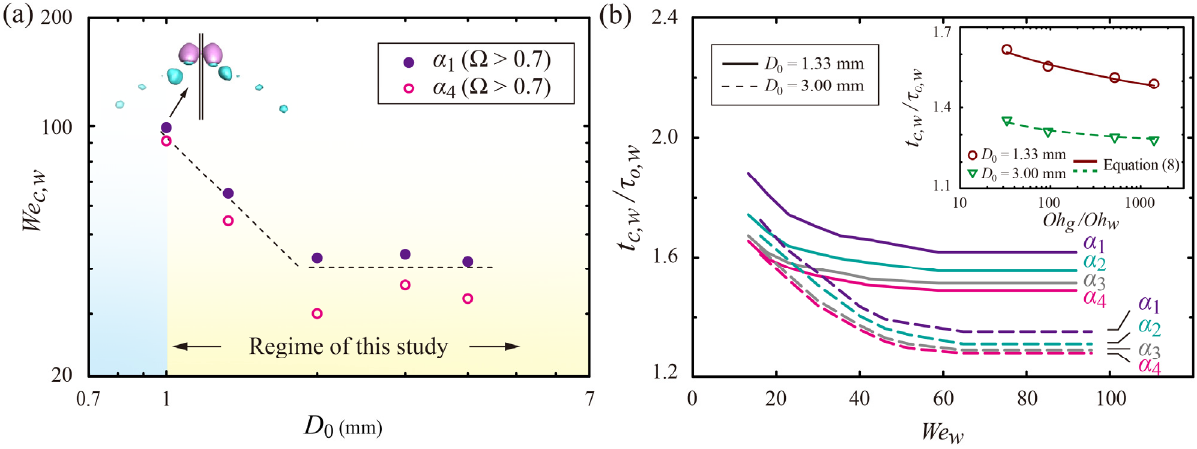
Figure 5. ( a ) We w thresholds for the separation under different drop sizes. Filled and open symbols represent the thresholds under the viscosity ratios of α 1 and α 4 , respectively. ( b ) Residence time of W-parts normalized by τ o,w as a function of We w at two distinct drop diameters. The inset represents the normalized residence time as a function of Oh g / Oh w , obtained from numerical data (symbols) and predictions from Equation (8) (lines) under the high- We w regime. The data regarding D 0 = 2.0 mm in ( a ) are reprinted with permission from [28]. Copyright 2022 AIP Publishing.